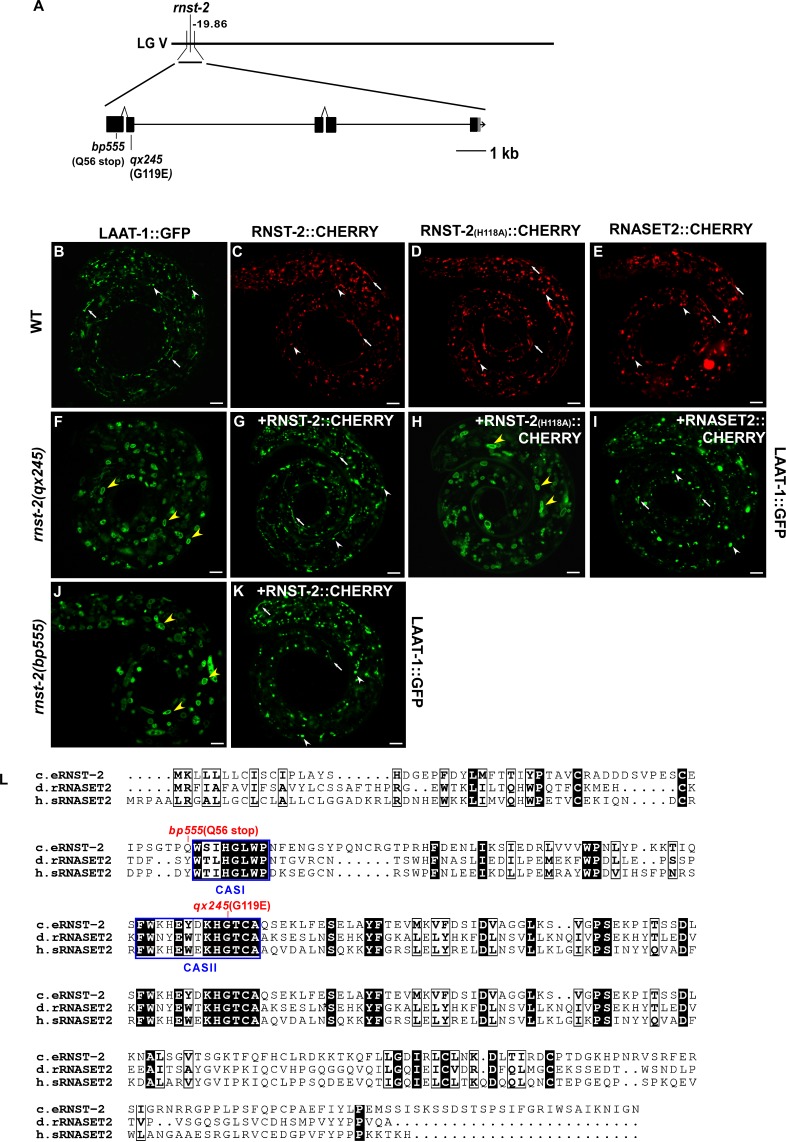
Molecular cloning of rnst-2.(A) Cloning of rnst-2. The top bar indicates the genetic position of rnst-2. The rnst-2 gene structure is shown with filled boxes representing exons and thin lines indicating introns. The arrow delineates the direction of transcription. The position of the mutation site in qx245 and bp555 is indicated. (B, F–K) Confocal ﬂuorescence images of lysosomes in the indicated strains at the L1 stage expressing LAAT-1::GFP. White arrowheads and arrows indicate globular and tubular lysosomes, respectively, and yellow arrowheads indicate enlarged lysosomes. (C–E) Confocal ﬂuorescence images of wild-type larvae expressing RNST-2::CHERRY (C), RNST-2(H118A)::CHERRY (D) and human RNASET2::CHERRY (E) driven by the rnst-2 promoter. Scale bars in (B–K): 5 µm. (L) Sequence alignment of C. elegans (c.e) RNST-2, Drosophila melanogaster (d.r) RNASET2 and human (h.s) RNASET2. Identical residues are shaded in black and similar ones are marked in white boxes. Blue boxes indicate two conserved catalytic active sites (CAS). Mutations identified in different rnst-2 alleles are in red.